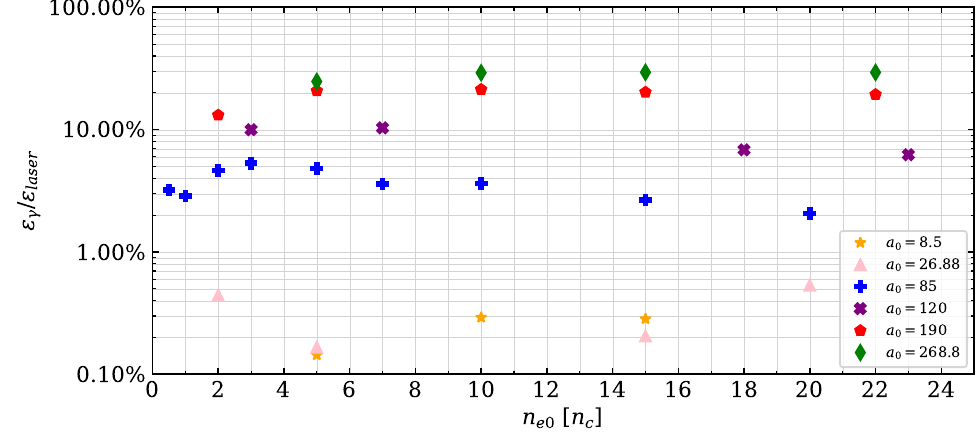
Figure 10. Absorption coefficient from the laser pulse to high energy photons at the optimum target thickness vs. target density for different laser intensities. Target parameters: L y = 30 µ m. Laser parameters: λ = 1 µ m, τ = 20 fs FWHM and w 0 = 12.5 µ